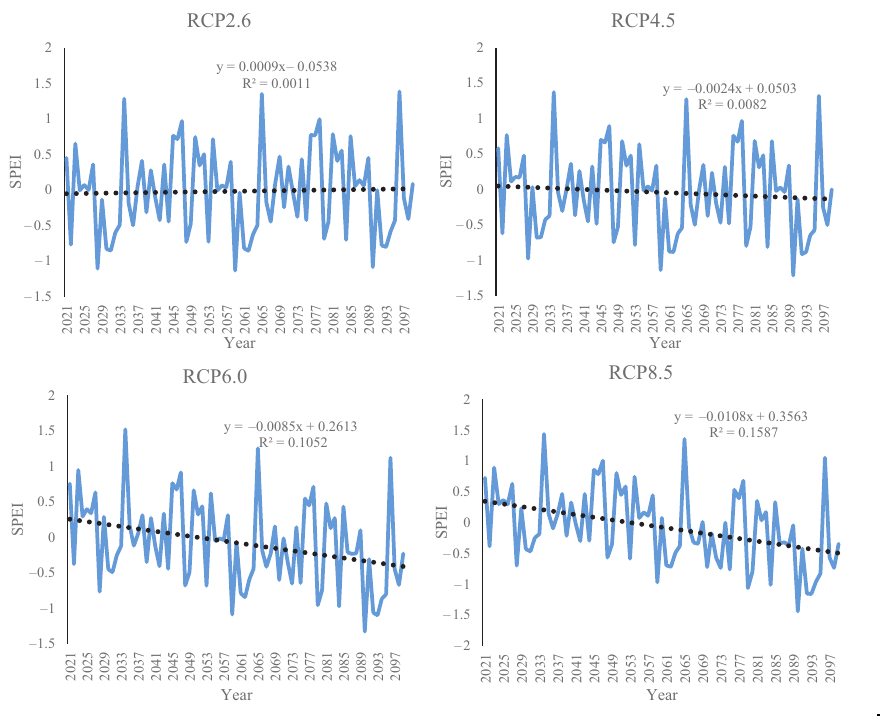
Figure 4. The change trend of annual SPEI in the Yellow River Basin under four RCP